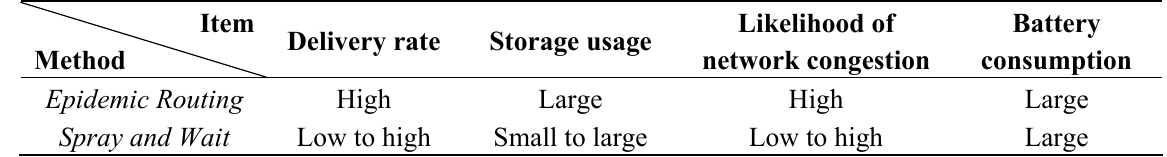
Table 1. Characteristics of the existing